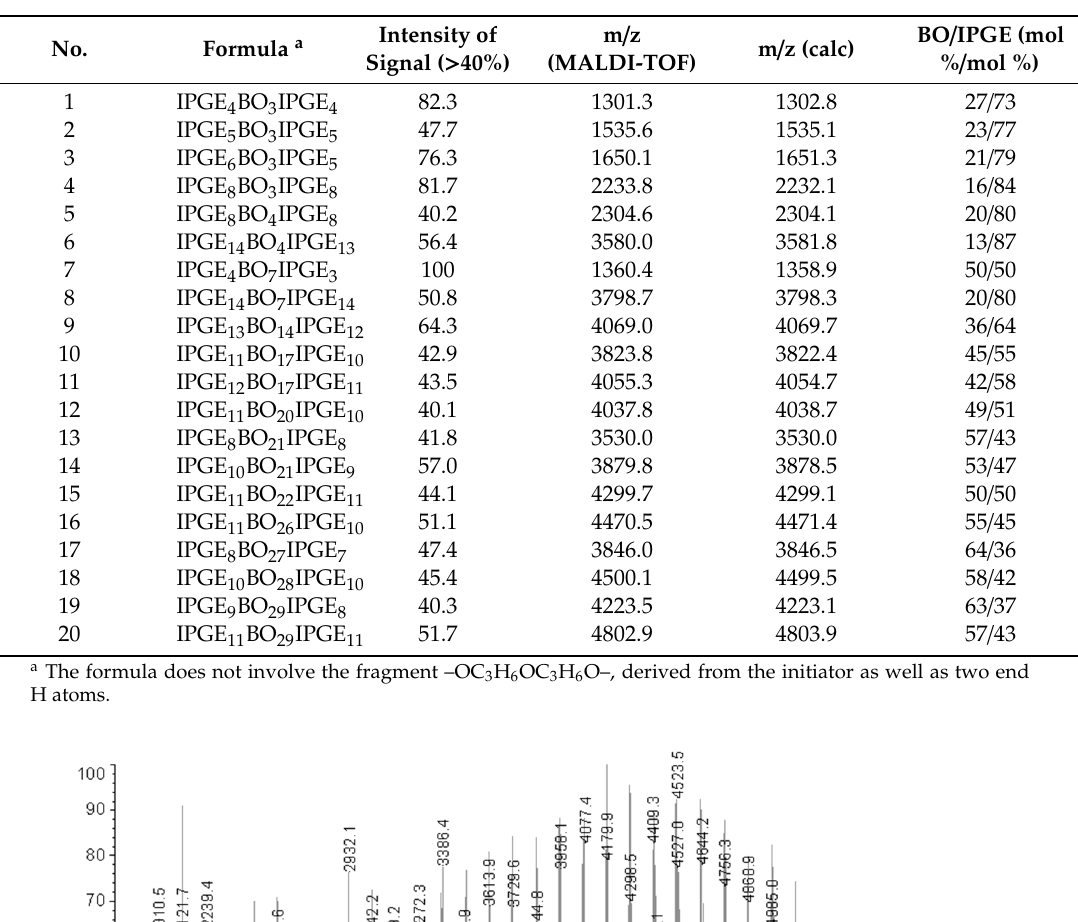
Table 4. Composition of PIPGE / PBO / PIPGE triblock copolyether-diol (18) determined by MALDI-TOF mass spectrometry.